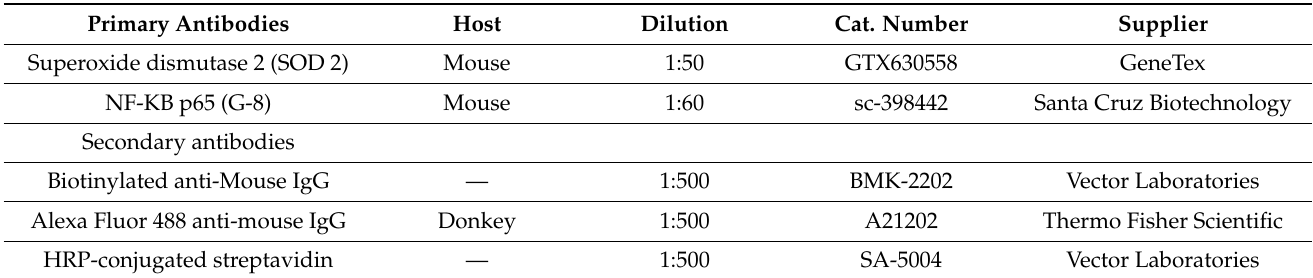
Table 3. Antibodies used for